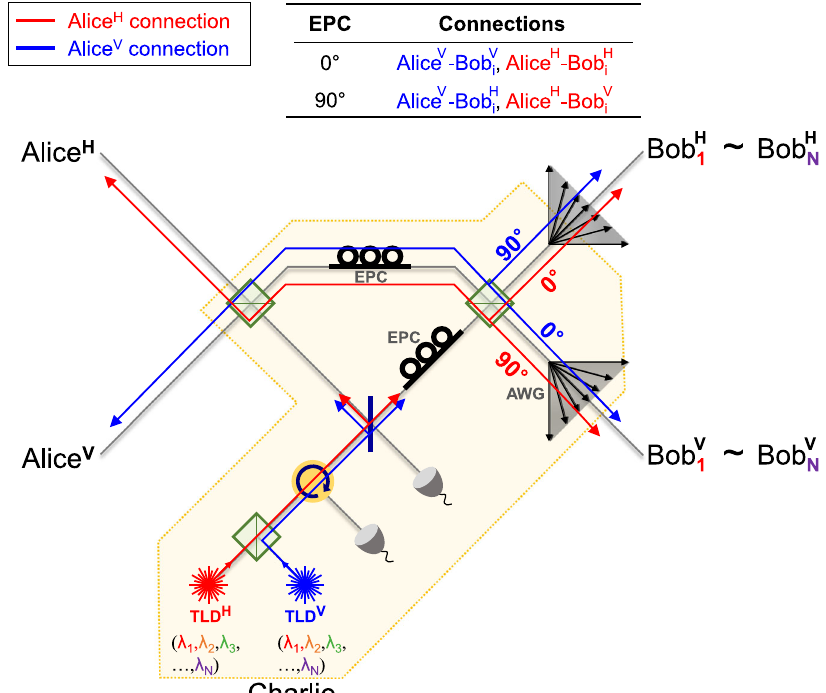
Fig. 2 Network connection based on the modulations of two electrical polarization controllers (EPCs). As shown in the table, by modulating EPCs to 0° (90°), Alice H and Alice V are connected to Bob H i (Bob V i ) and Bob V i (Bob H i ), respectively. The paths for the Alice H and Alice V connections are represented by red and blue solid lines, respectively. The de fi nitions of the abbreviations are as follows. TLD wavelength-tunable laser driver, EPC electrical polarization